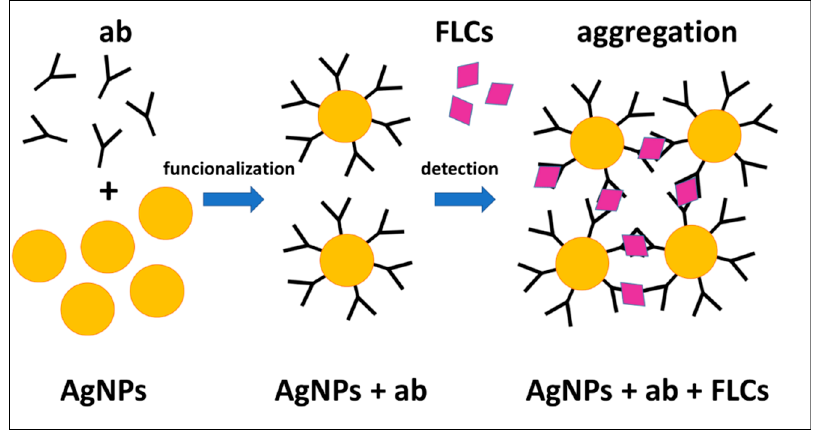
Figure 7. The mechanism of antigen detection. Specific antibodies were attached to the citrate- stabilized AgNPs. A further addition of the protein antigens (FLCs) caused the nanoparticles to aggregate.